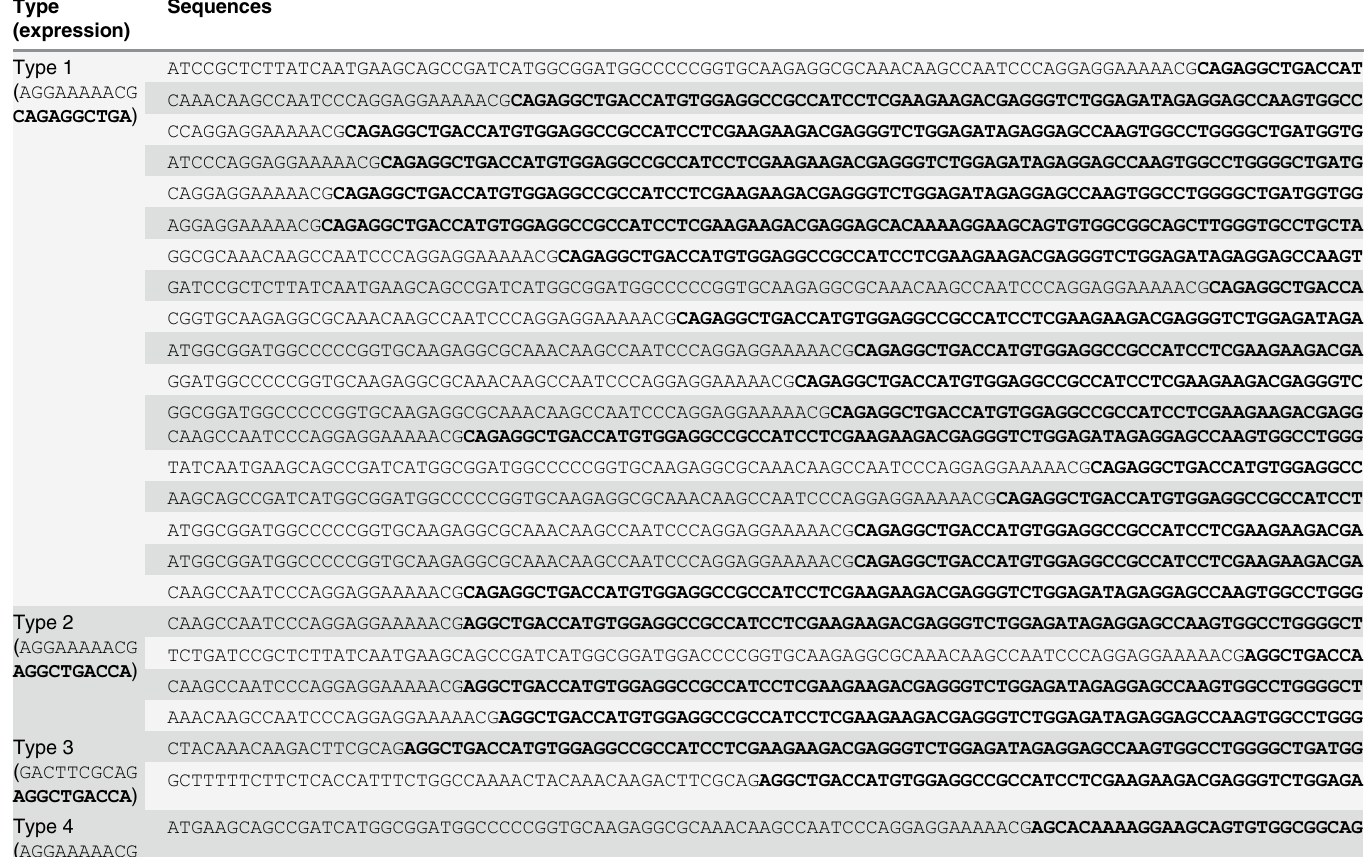
Table 3. Sequences retrieved with the «grep» command using the expressions " AGGAAAAACGCAGAGGCTGA ", " AGGAAAAACGAGGCTGACCA ", " GACTTCGCAGAGGCTGACCA ", and " AGGAAAAACGAGCACAAAAG " which correspond to type 1, type 2, type 3 and type 4 of ZEB2-BCL11B fusion tran- script, respectively. The sequences of BCL11B are in